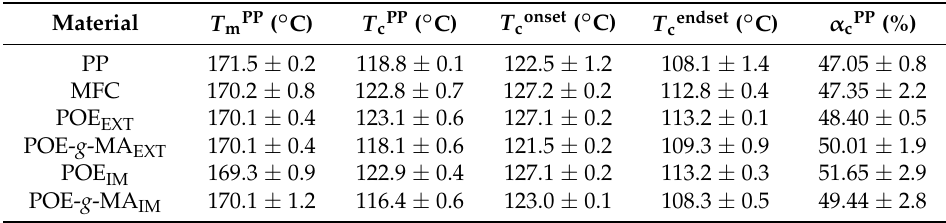
Table 3. Thermal properties of PP, MFC, POE EXT , POE- g -MA EXT , POE IM , POE- g -MA IM during heating and